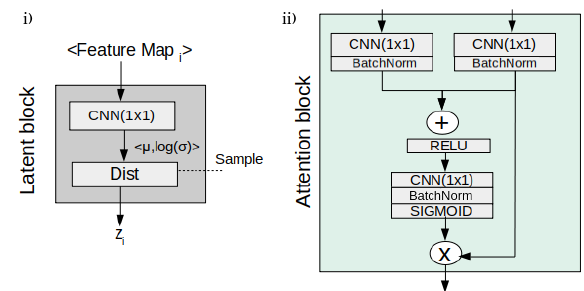
Figure 2. Details of the latent ( i ) and the attention ( ii ) blocks of the U-HPNet.